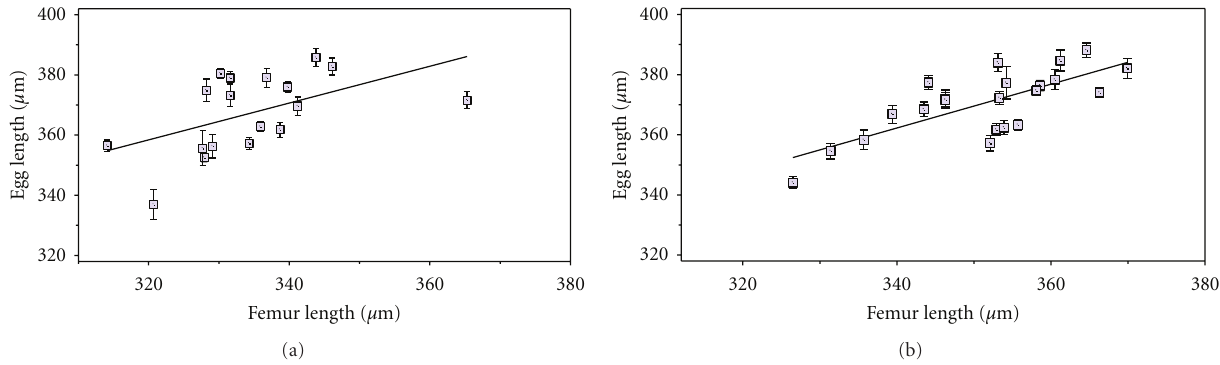
Figure 2: Mean ± SEM egg length versus femur length of combined mothers fed only high quality prey in trials 1 (a) and 2 (b) over combined harvest dates. The regression line defines a significant relationship between mean egg length ( Y ) versus femur length ( X ), simple linear regression Y = b o + b 1 X. In trial 1: b o , 162.6; b 1 , 0.6; r 2 = 0.27; n , 18 observations (mothers). In trial 2: b o , 114.6; b 1 , 0.7; r 2 = 0.55; n , 22 observations (mothers). Refer to Table 1 for the ANOVA statistics of each regression analysis.